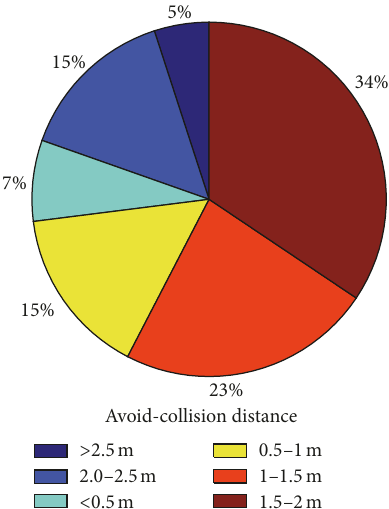
Figure 3: The investigation results about the avoid-collision dis- tance.